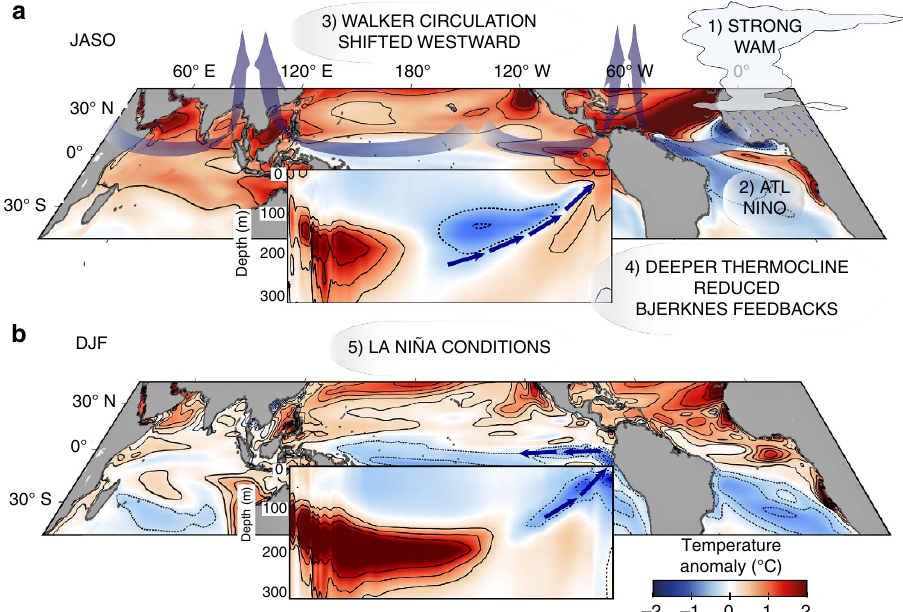
Figure 8 | Schematic representation of the mechanisms behind the changes in ENSO variability and mean state. ( a ) Changes in the strength of the WAM and location of the ITCZ in summer (JASO) (1) trigger an Atlantic Nin˜o response and damp its variability (2). These conditions over the equatorial Atlantic shift the Walker circulation westward, forcing a divergent flow in the central Pacific (3). This flow cools the western Pacific and warms the eastern Pacific, with a consequent shallowing of the thermocline in the west and a deepening in the east (4) (vertical profile insert). The deepening of the thermocline and weakened upwelling in the eastern Pacific during the El Nin˜o developing season reduces the strength of the Bjerknes feedback (4). ( b ) The thermocline anomalies in the central Pacific travel eastward reaching the eastern Pacific during winter favouring a climatological La Nin˜a mean state in winter